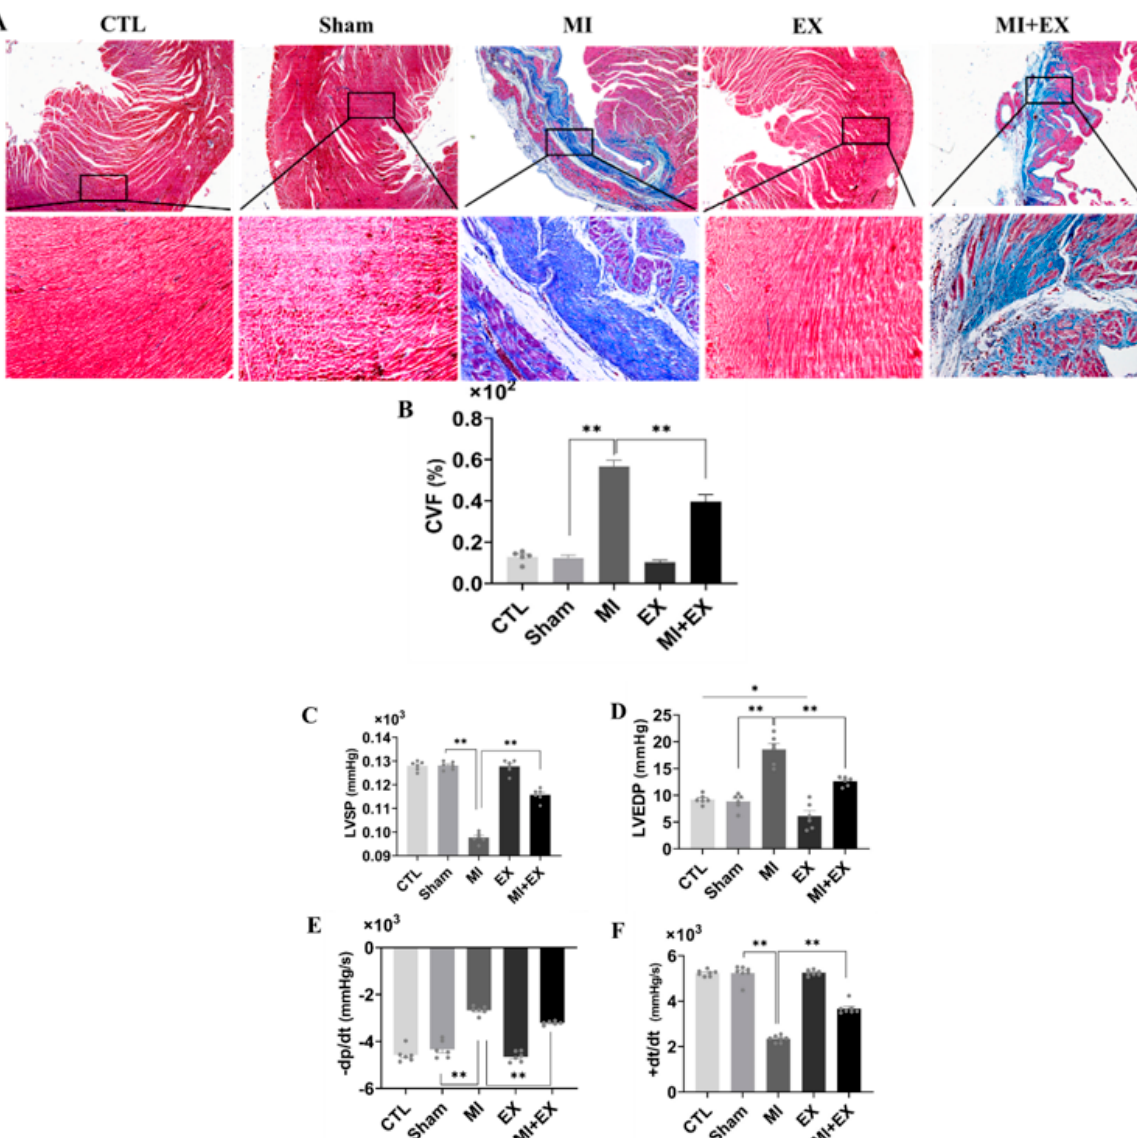
Figure 6. Exercise training mitigates cardiac dysfunction after MI. Blue-stained collagen, a fibrosis marker, red-stained cardiac muscle fibers, and dark brown nuclei visualized by microscopy (scale bar = 0.61 µ m). ( A , B ) The areas of no Masson’s trichrome staining (cardiac muscle fibers) and Masson’s trichrome-positive staining (blue-stained collagen) were digitally measured to determine the collagen volume fraction (CVF %) ( n = 3). The systolic and diastolic function of the left ventricle was assessed by measuring cardiac hemodynamic parameters including ( C ) LVSP, ( D ) LVEDP, ( E ) − dp/dt, maximum pressure decreasing rate, and ( F ) +dt/dt, maximum pressure increasing rate ( n = 6.7). The values are presented as the mean ± SEM. CTL, normal control; MI, myocardial infarct; EX, CTL + exercise; MI + EX, MI + exercise. * p < 0.05, ** p < 0.01.